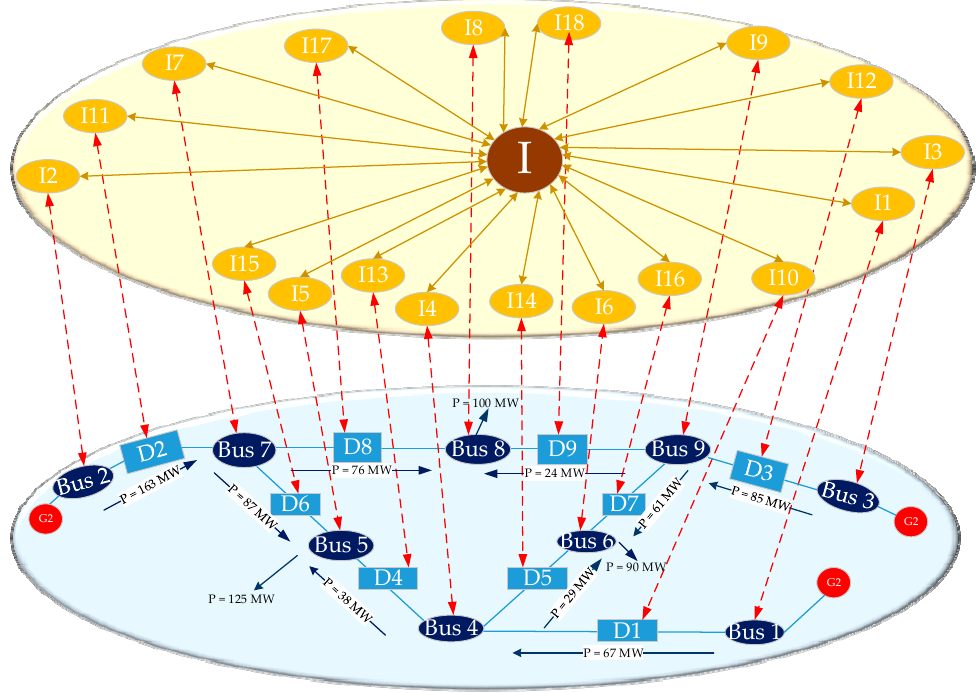
Figure 2. Three-generator nine-bus power system and its cyber system.